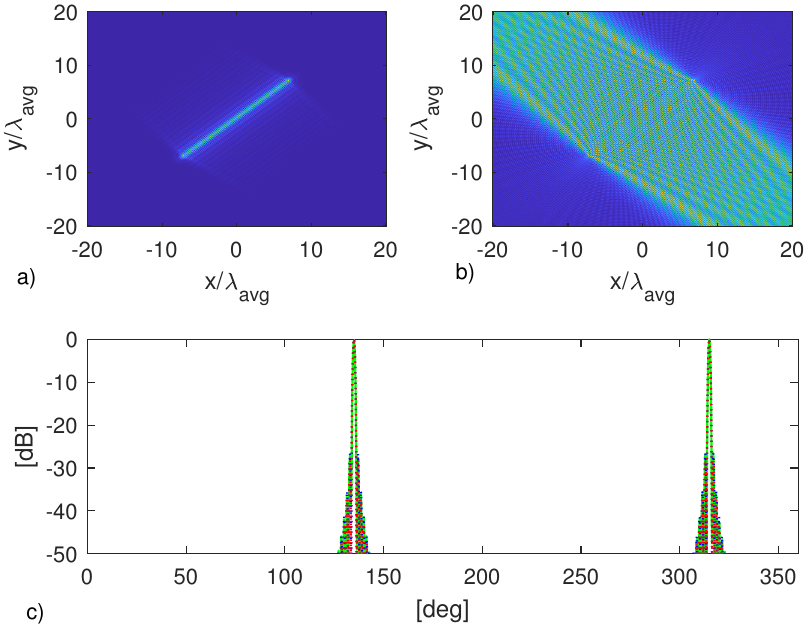
Figure 6. Object in Figure 5a. ( a ) Multi-frequency image. ( b ) Single-frequency image. ( c ) Normalized RCS at f = 4.5 GHz. The green line refers to the actual RCS, while the blue and red lines to the ones computed from multi-frequency and single-frequency images,